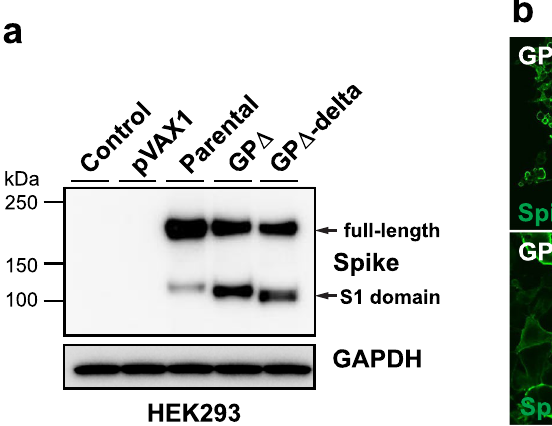
Figure 2. Development of GP∆-DNA vaccine targeting the delta variant. ( a ) Delta variant-specific mutations (Spike mutation of B.1.617.2: T19R, G142D, E156G, del157/158, L452R, T478K, P681R, and D950N) that were induced into the GP∆-DNA vaccine construct. Expression of the delta variant spike was confirmed through western blotting. GAPDH expression was used as a loading control. ( b ) Localization of spike expression in HEK293 cells, assessed through immunocytochemical analysis. Nuclei were stained by DAPI. Scale bars: upper panel = 50 μm, lower panel = 20